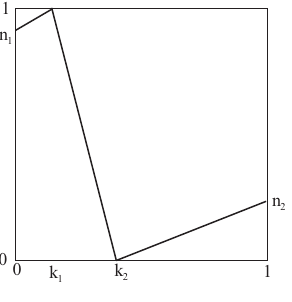
Figure 7. Normalized 1-D